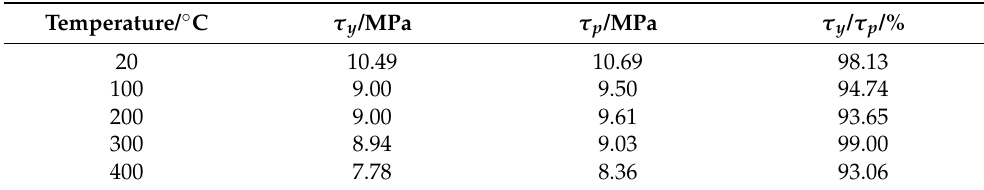
Table 2. Yield stress under various